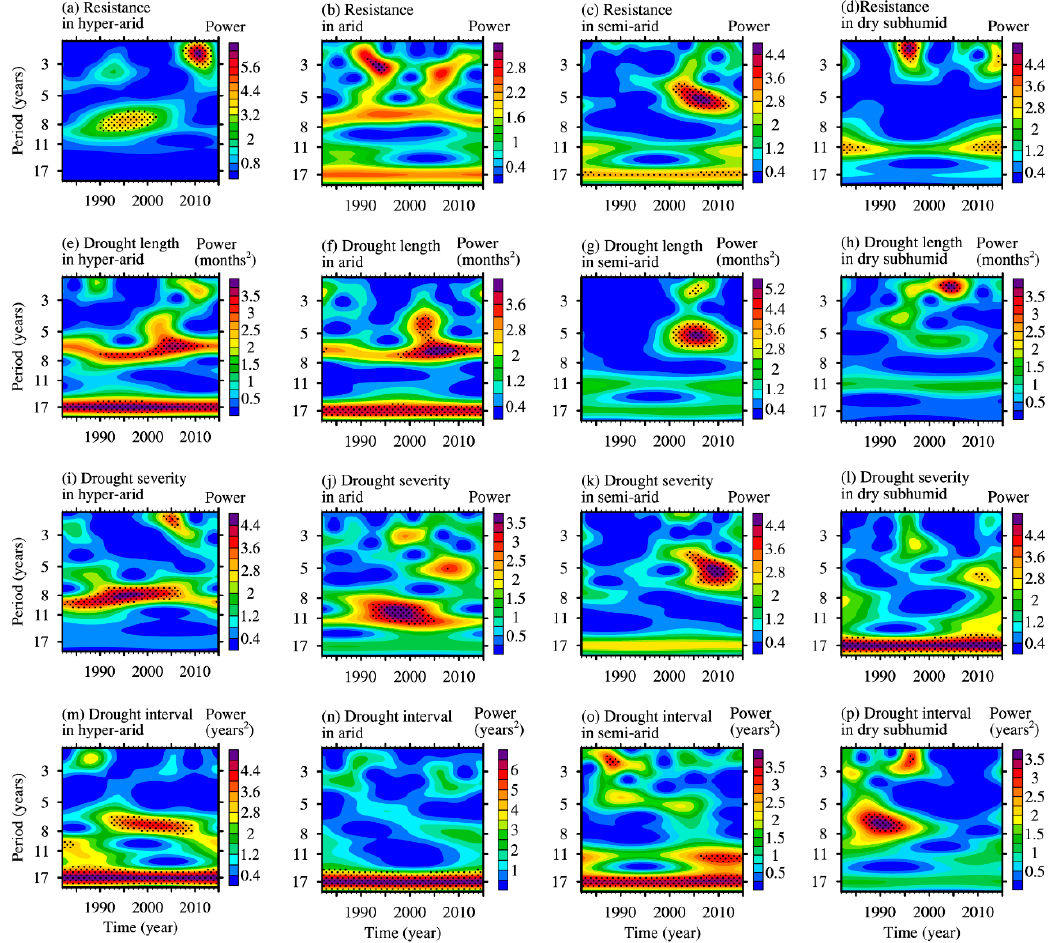
Figure 3. The wavelet power spectrum of ( a – d ) resistance, ( e – h ) drought length, ( i – l ) severity, and ( m – p ) interval in ( a , e , i , m ) hyper-arid, ( b , f , j , n ) arid, ( c , g , k , o ) semi-arid, and ( d , h , l , p ) dry sub-humid regions between 1982 and 2015. The power of the quasi-periodicity increases with the blue-green- yellow-red-purple colors, and black dots indicate significance at the 0.05 level.